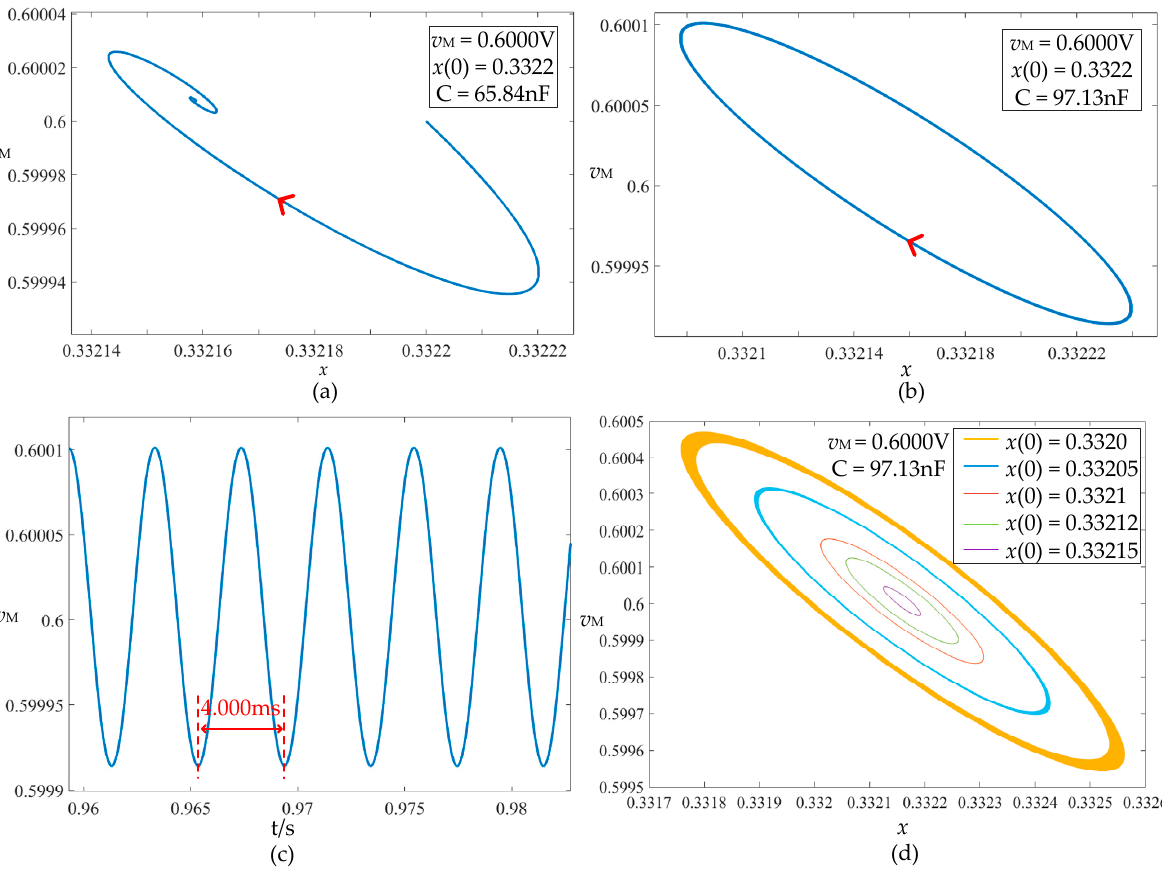
Figure 10. Simulation of memristor oscillation circuit: ( a – c ) system initial value V = 0.6000 V and x = 0.3322 and ( d ) increasing oscillation amplitude, if the initial value is far from the equilibrium point.